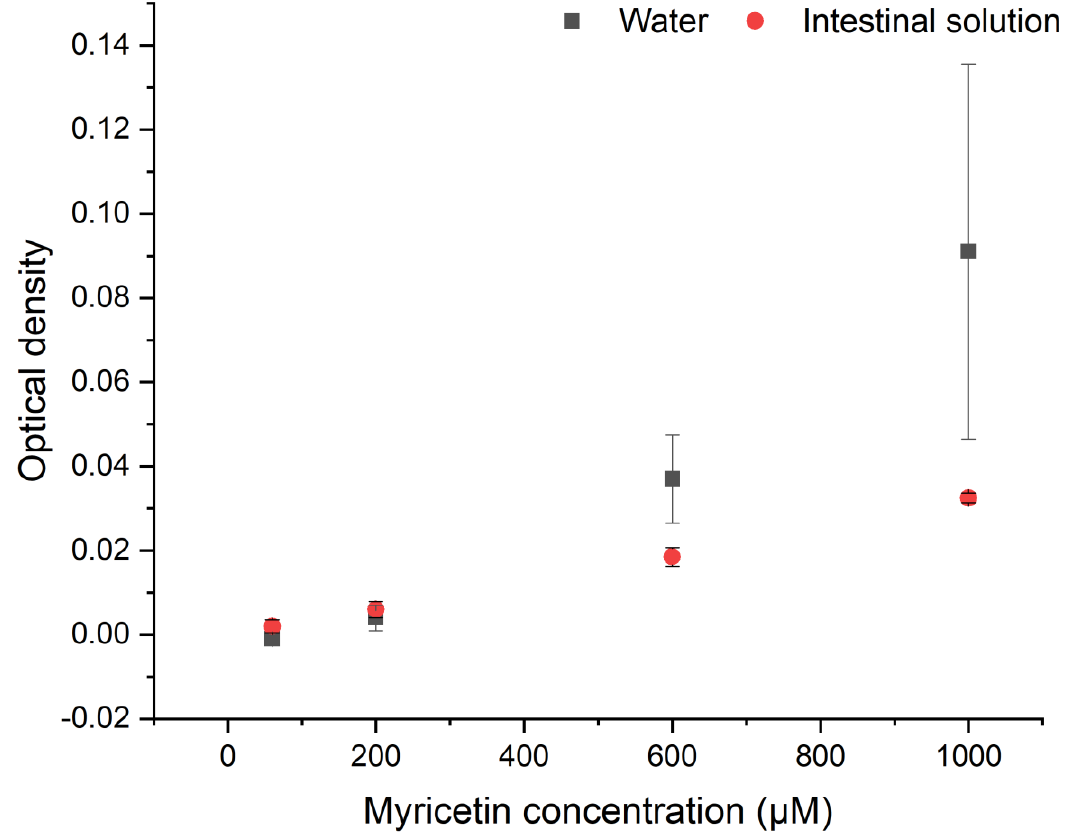
Figure 1. Aggregate formation of myricetin in water and intestinal solution for four different concentrations at 37 °C. The optical density was measured at 37 °C after 2 h of incubation at a wavelength of 800 nm. The error bars represent the pooled standard deviation from duplicates.